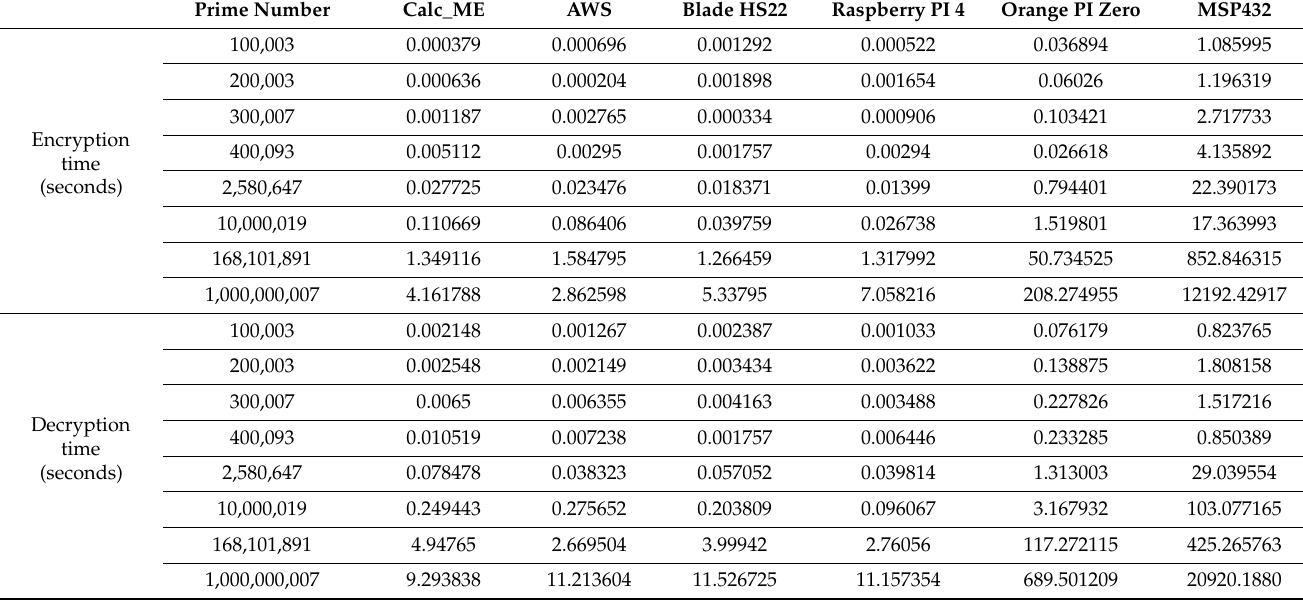
Table 3. Encryption/decryption times elapsed for generating three keys with different values of the chosen prime number p .